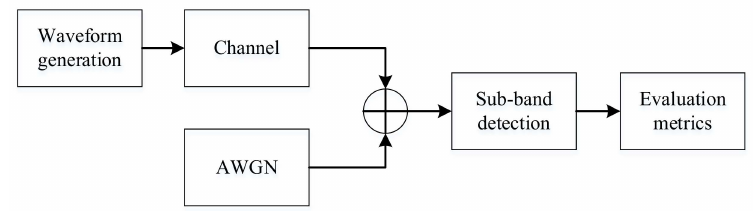
Figure 6. Schematic of